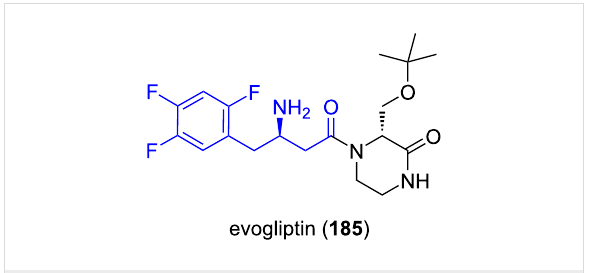
Figure 8: Structure of evogliptin ( 185 ), an antidiabetic drug.